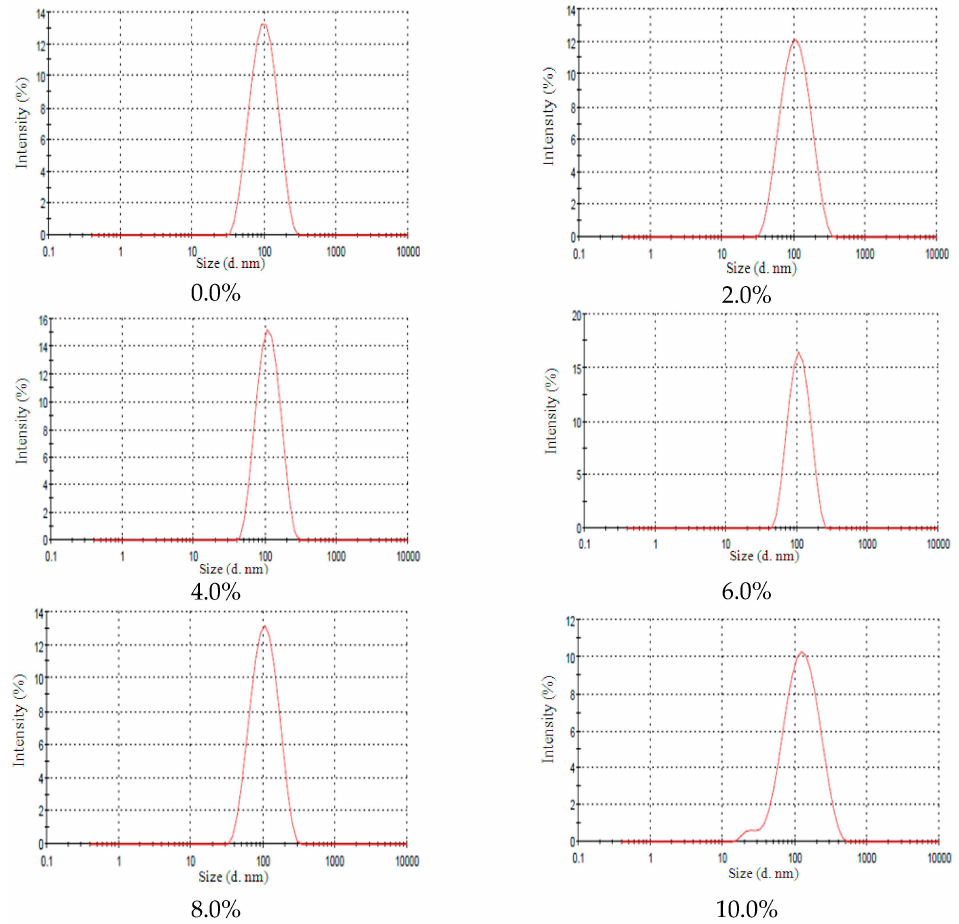
Figure 4. NE-EL size distribution at different EL concentrations (0.0%; 2.0%; 4.0%; 6.0%; 8.0% and